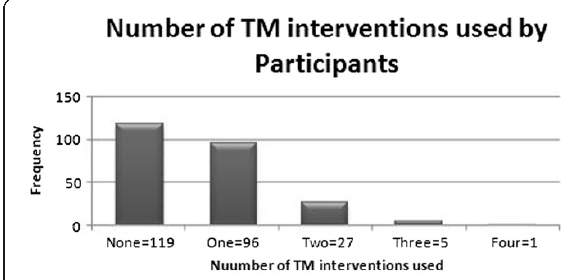
Figure 2 The number of women who used different numbers of TMs concurrently during their pregnancies. Figure 2 shows the number of women who used different numbers of traditional medicine interventions during their pregnancy. Among users, the majority (n=96) used only a single intervention, 27 users used two interventions concomitantly while 5 employed three interventions. Only one user reported the use of four interventions during a single